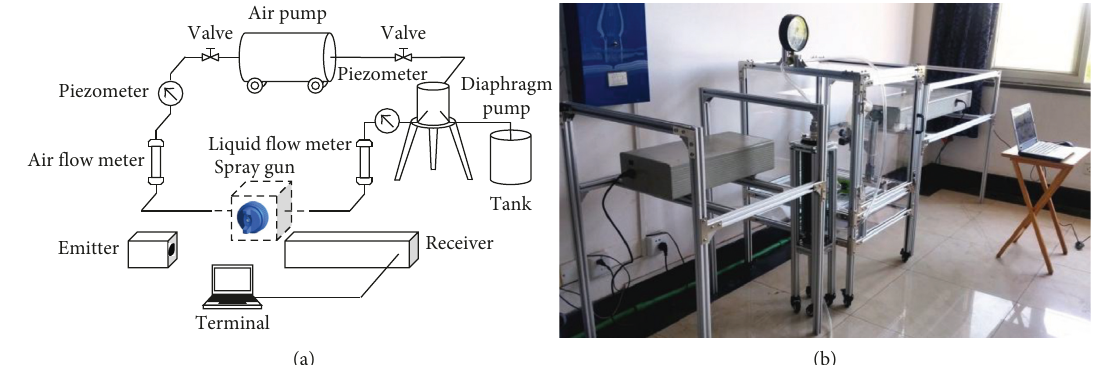
Figure 4: Schematic of laser particle analyzer measuring